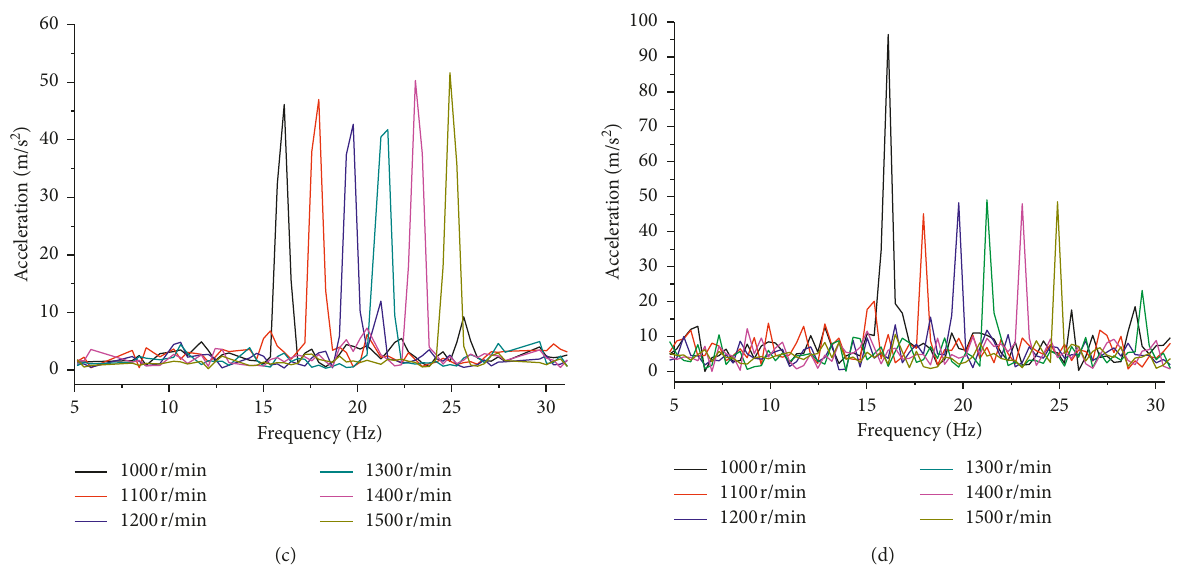
Figure 13: Vibration acceleration near rotation frequency of the JW6314 three-phase motor. (a) Sensor 1 on the base. (b) Sensor 2 on the cylinder. (c) Sensor 3 on the base. (d) Sensor 4 on the